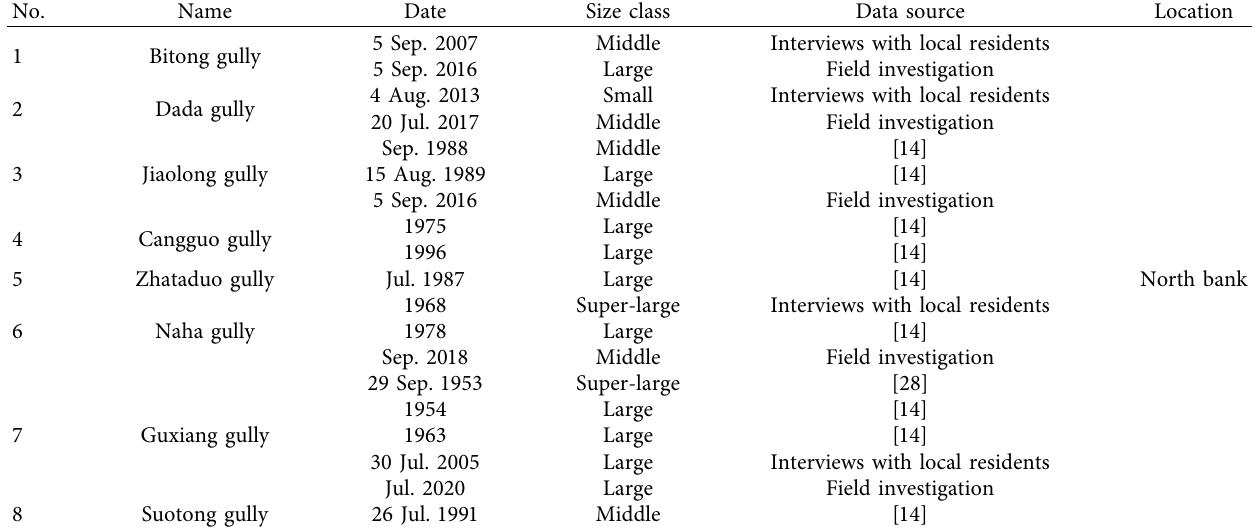
Figure 3: Debris flow events from investigation in the field. (a) Bitong debris flow in 2016; (b) Dada debris flow in 2017. (c) Guxiang debris flow in 2020. (d) Jiaolong debris flow in 2016; (e) Chidan debris flow in 2016. (f) Songrao debris flow in Table 1: Typical debris flows along the Parlung River from Bomi to Suotong (e.g. 1–13 in Figure 1). No.